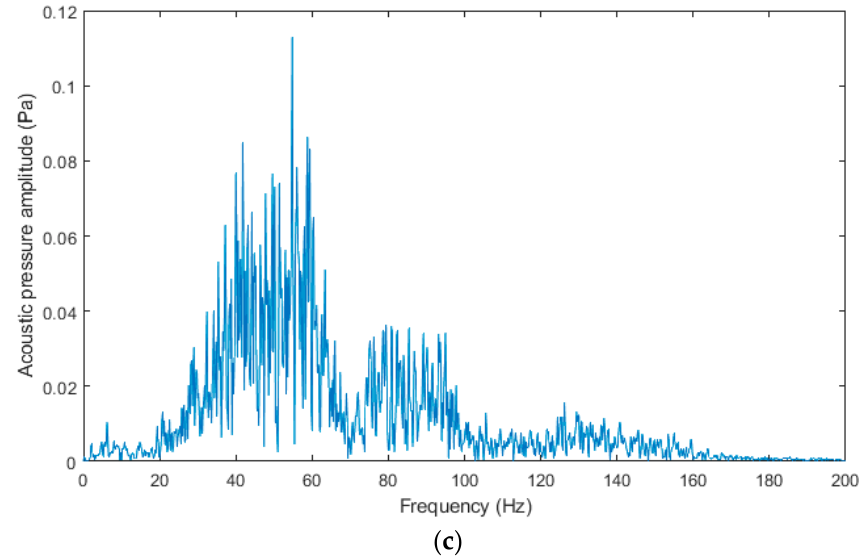
Figure 15. The frequency spectra from the blasting operation recording of March 11, 2019: ( a ) Seismic apparatus BRS32; ( b ) interferometric sensor; ( c ) acoustic sensor.